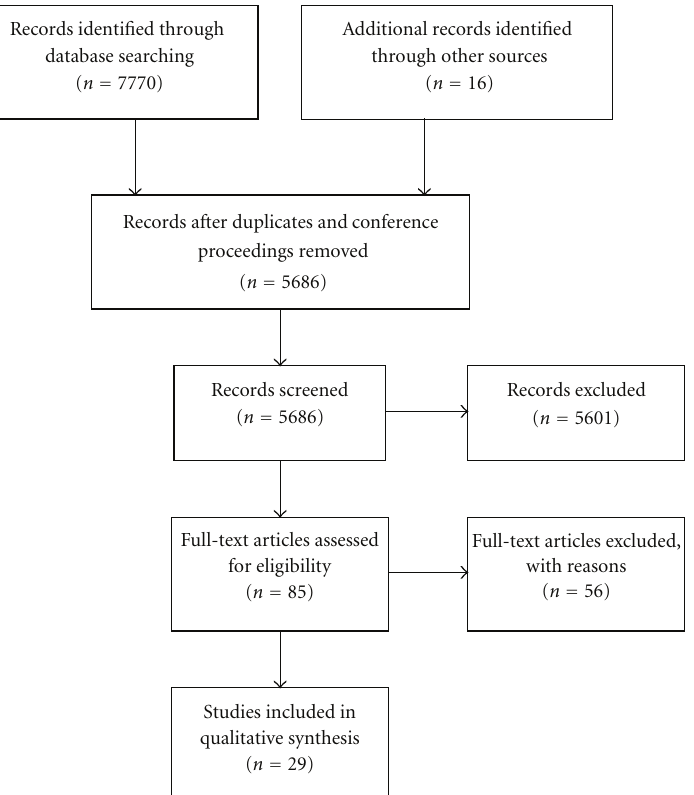
Figure 1: Flow of articles through the search